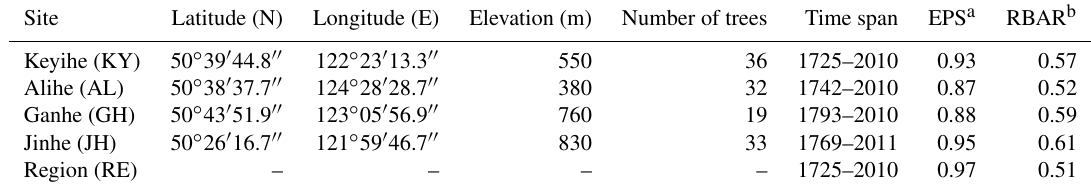
Table 1. Site description and statistical characteristic of the Pinus sylvestris var. mongolica dendrochronologies in the Daxing’an Mountains.